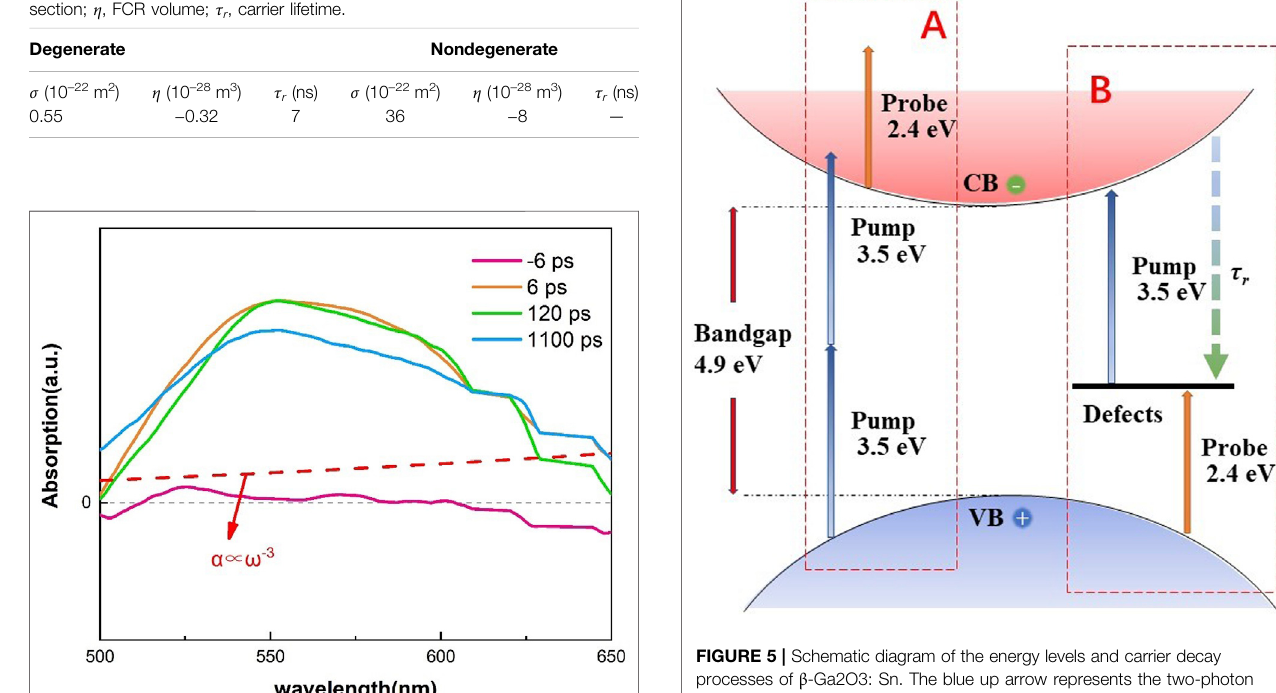
FIGURE 4 | Transient absorption spectra of β -Ga2O 3 : Sn in 500 – 650 nm.